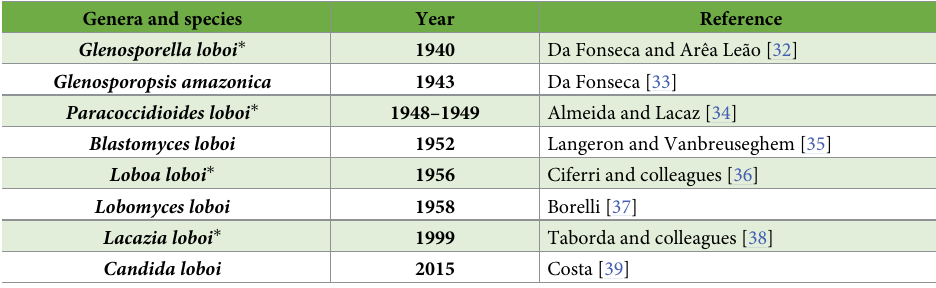
Table 2. Jorge Loˆbo’s disease etiology through the